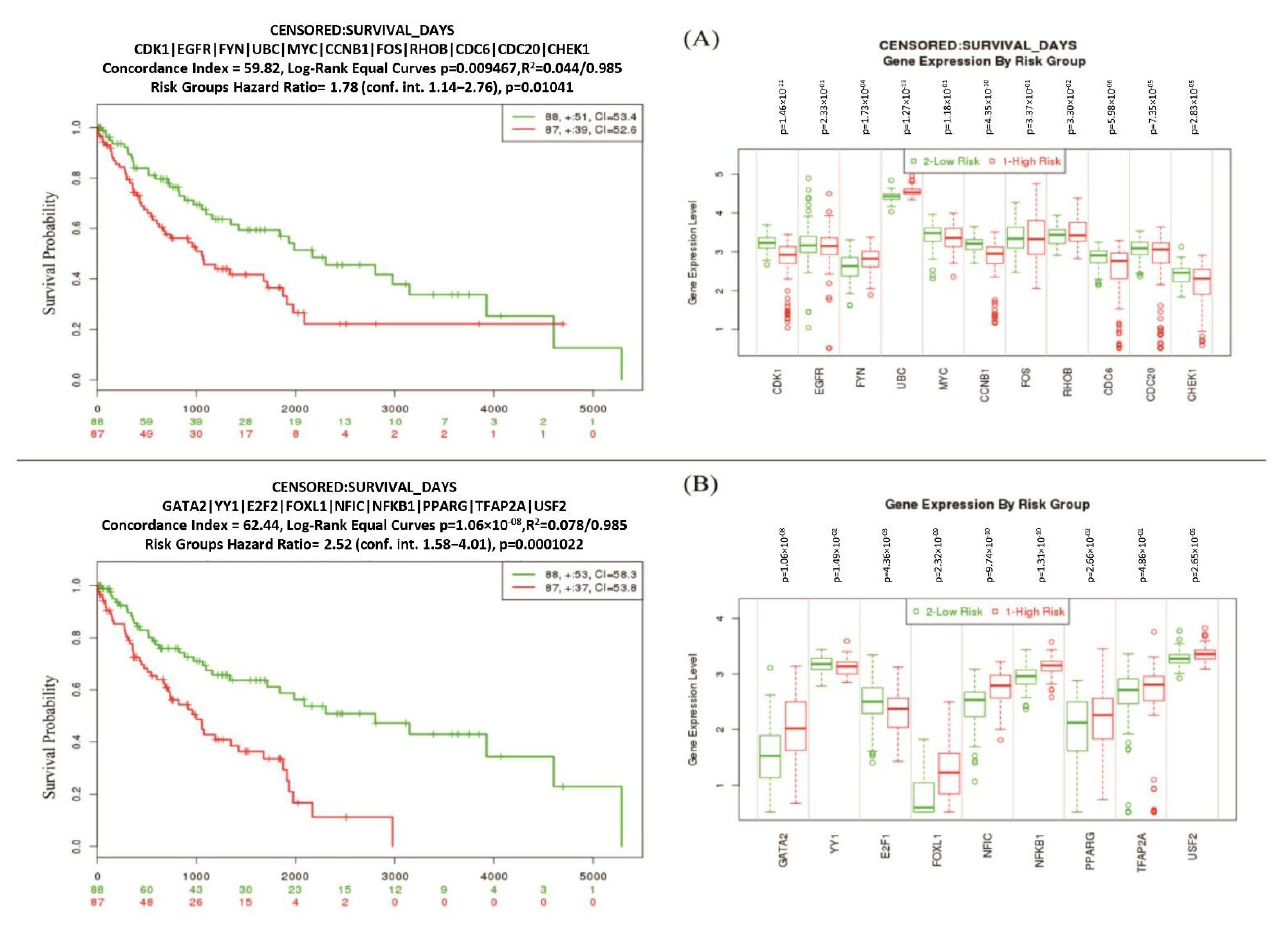
Figure 8. The risk group discrimination performance by the multivariate survival probability curves (left) and box plots (right) based on ( A ) hub-DEGs/proteins and ( B ) key TFs (transcription factors) proteins.